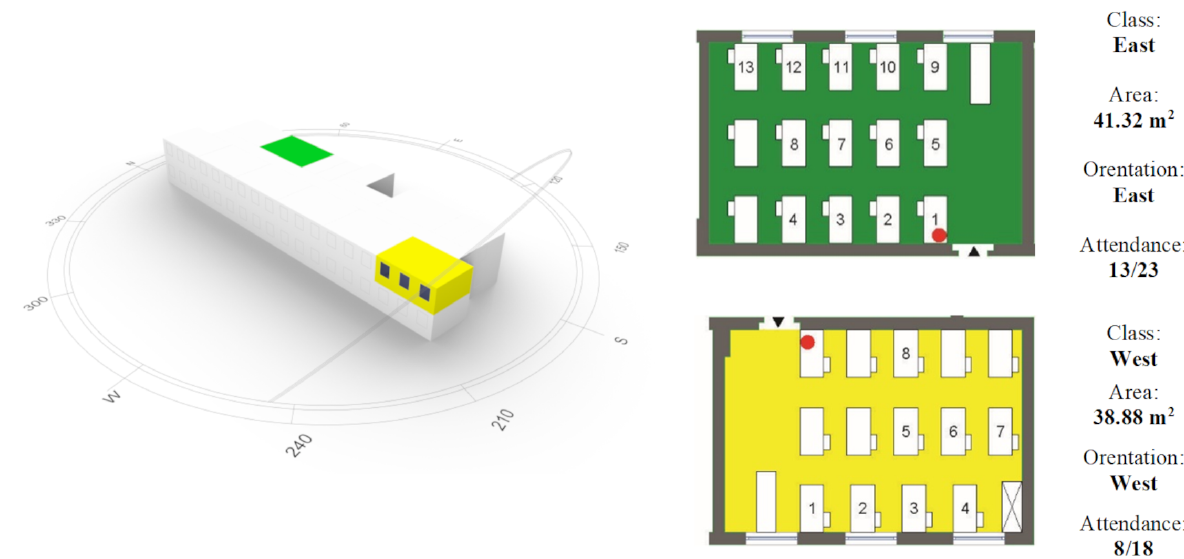
Figure 1. School building with sun path for the considered class period (November 16 th –18 th ), classrooms configurations and position of nEMoS devices (in red) during the